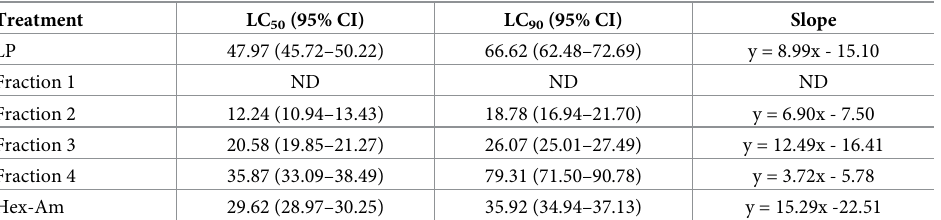
Table 2. LC 50 and LC 90 values for Leptospermum scoparium essential oil and its fractions and emulsions produced with hexadecyl ammonium chloride amylose inclusion complexes. ND, not determined because it was outside the range of concentrations tested. LP, Leptospermum scoparium